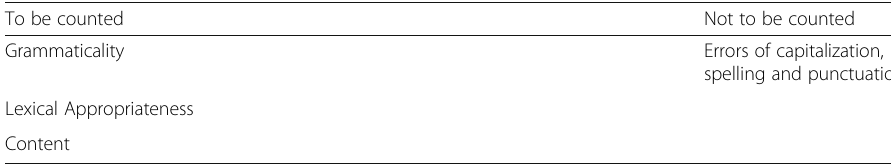
Table 3 Checklist of assessing writing To be counted